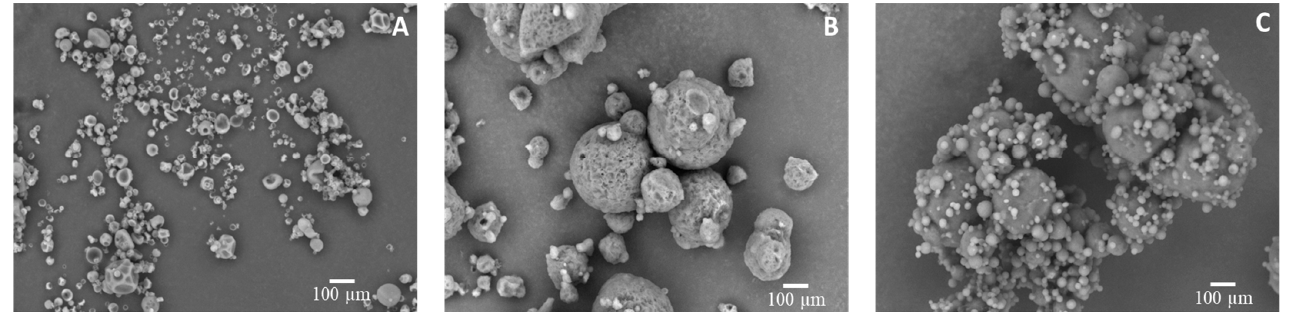
Figure 3. Scanning electron micrographs (1000× magnification) of microparticles obtained by ( A ) spray drying (SD33), ( B ) spray chilling (SC40), and ( C ) spray drying and chilling combination (SDC20). The numerical suffix denotes the core/wall material ratio of the selected formulation. SC40 and SDC20 microparticles had spherical shapes of different sizes. The